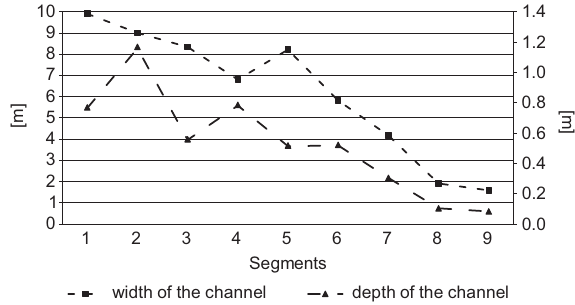
Fig. 3. The average width of the riverbed (left axis) and the depth of the channel (right axis) in the measured Oľšava River longitudinal profile section.